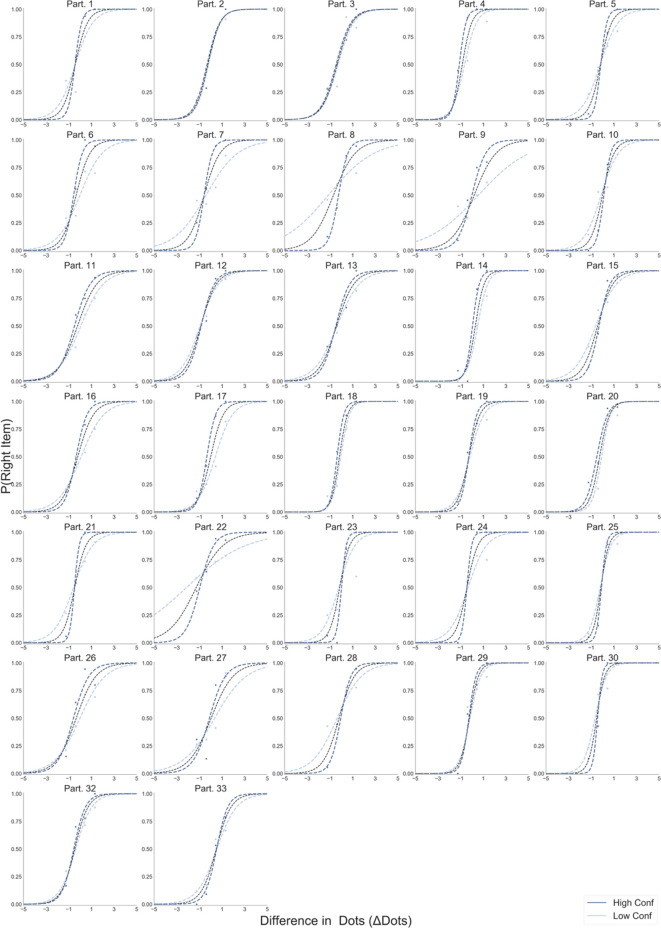
Logistic regression predicting choice from the difference in number of dots between the two circles (∆Dots).All participants in the Perceptual Experiment, most frame, are presented. Light blue lines depict the logistic fit calculated using only low confidence trials. Dark blue lines show the logistic fit only for high confidence trials. Segmented black line considers the logistic regression calculated with all the trials.